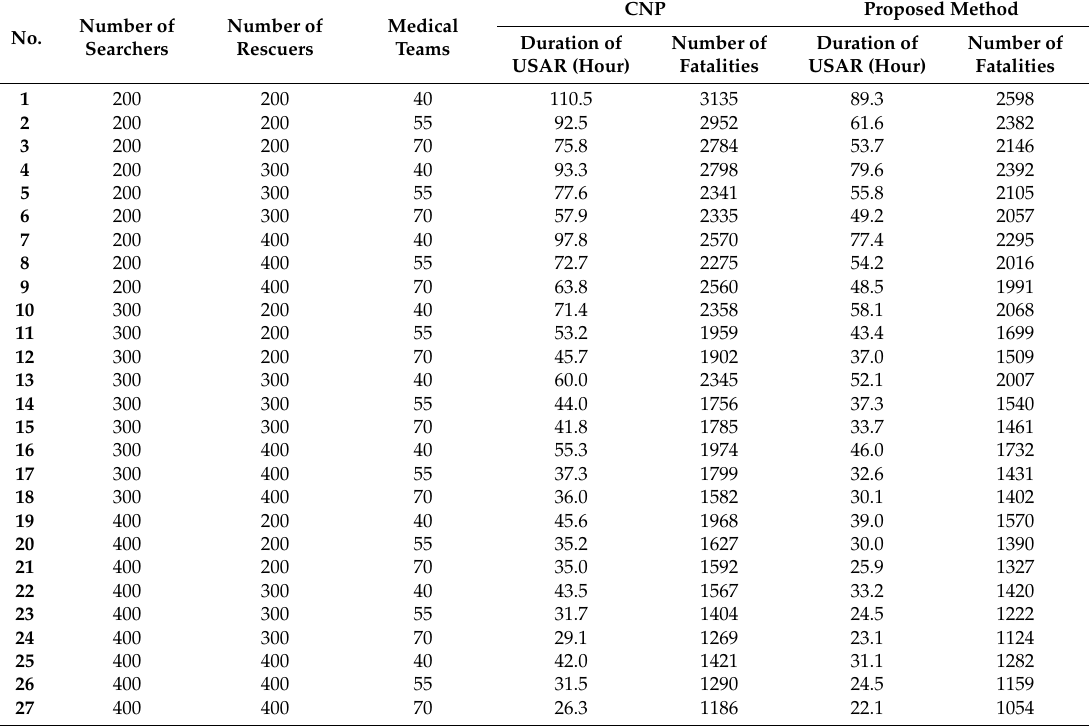
Table 5. A comparison of the CNP and the proposed